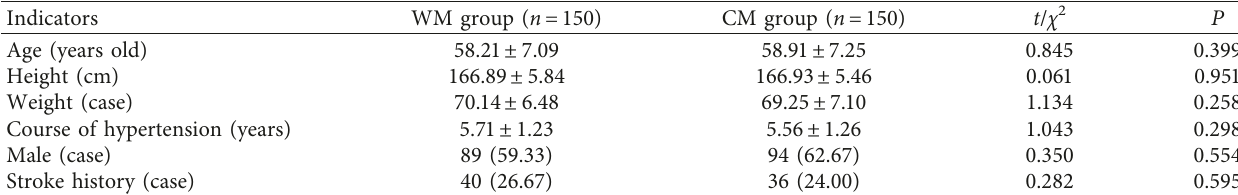
Table 1: Comparison of general information for both